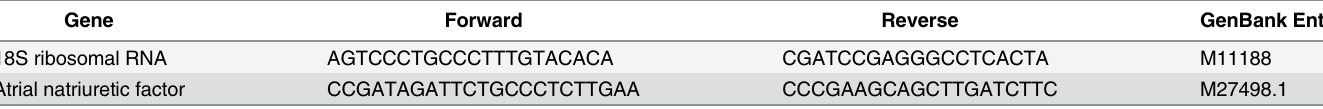
Table 1. Primer sequences used in real time quantitative RT-PCR.